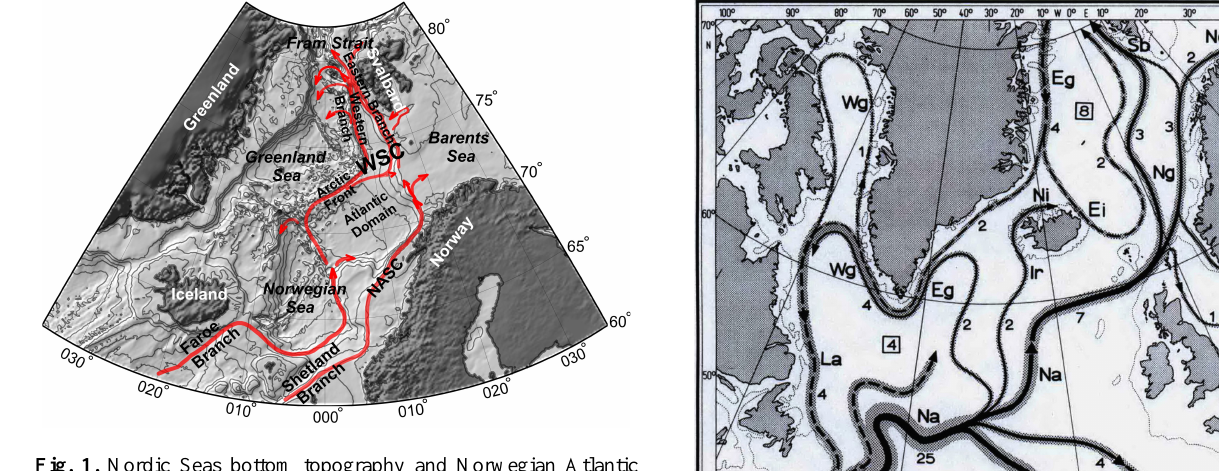
Fig. 1. Nordic Seas bottom topography and Norwegian Atlantic Current – West Spitsbergen Current system.